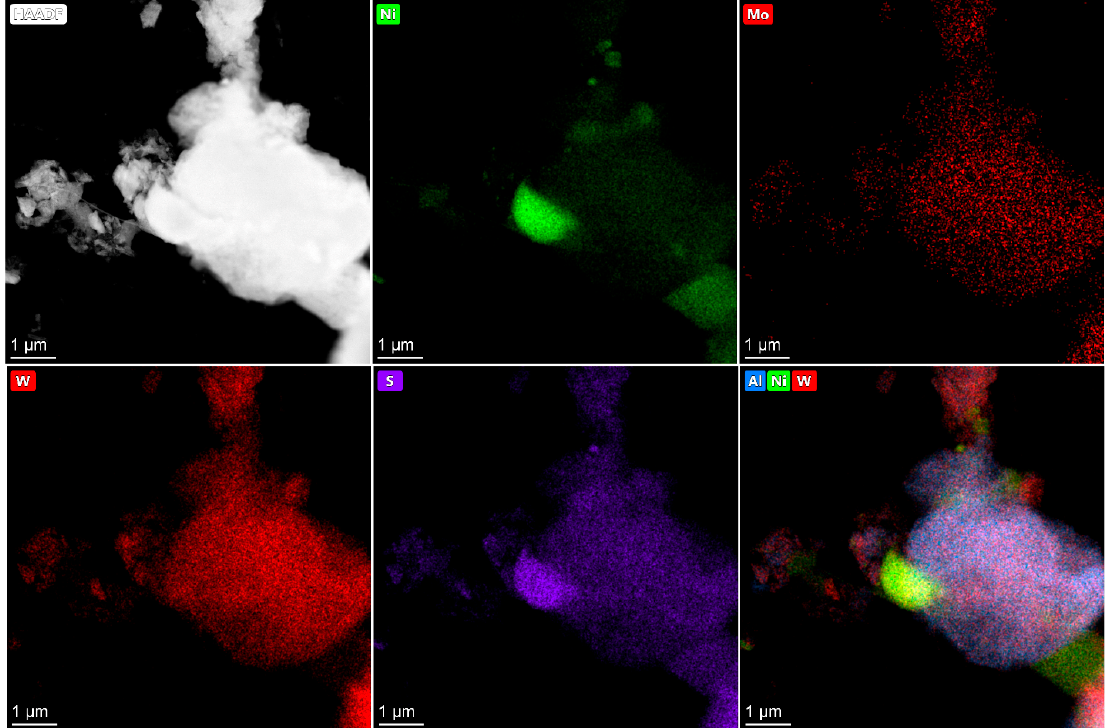
Figure 8. HAADF data on the c—Ni 1 Mo 0.25 W 0.75 sulfide catalyst after testing. The HAADF images of c—Ni 1 Mo x W y catalysts also demonstrate areas with sulfide active metals distributed on alumina. This behavior is similar to the bimetallic c—Ni 1 Mo